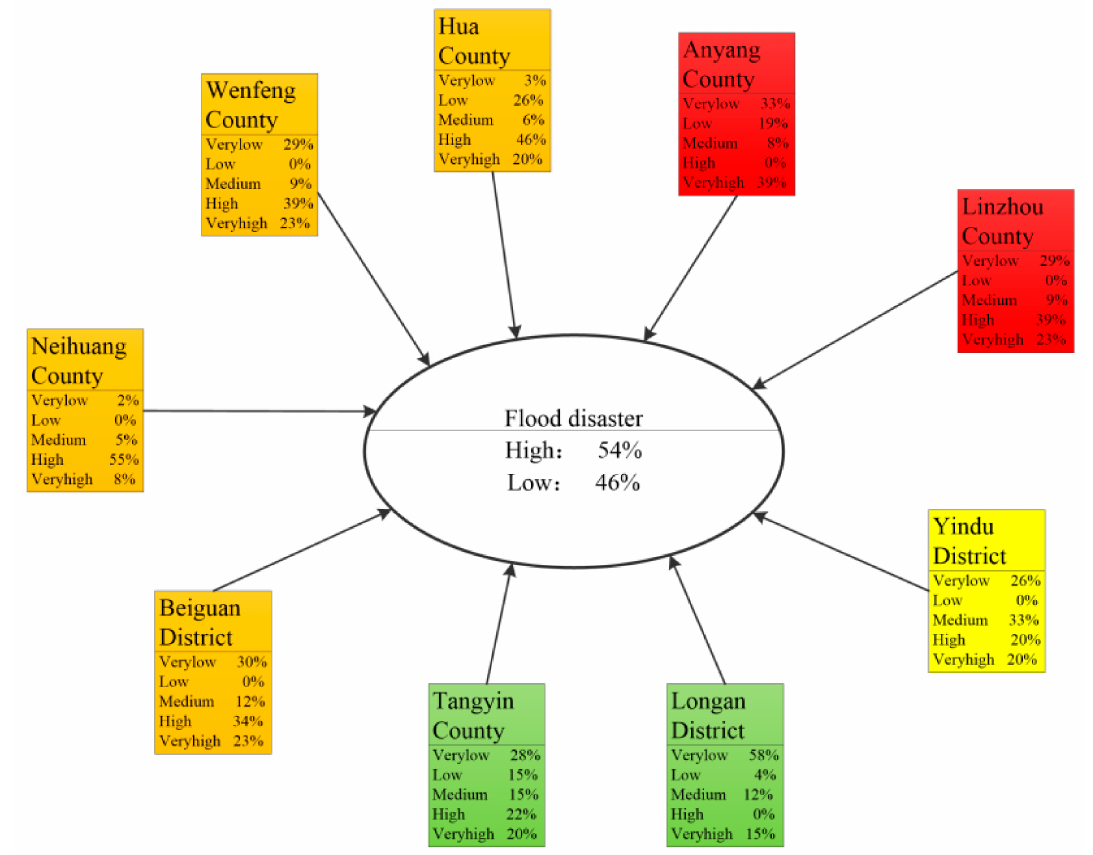
Figure 7. Flood disaster risk evaluation model based on emergy theory and cloud